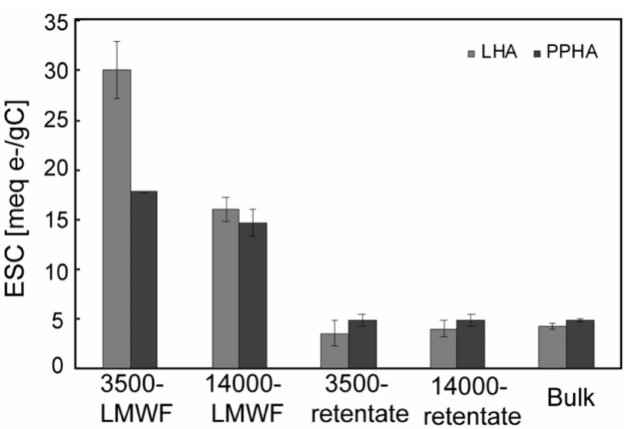
Figure 6. Comparison of electron shuttle capability between LHA and PPHA with different molecular weight.